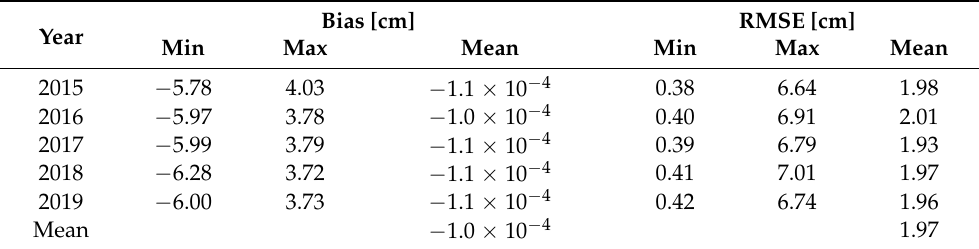
Table 2. Error statistics of the SH_set dataset compared to the ERA-5